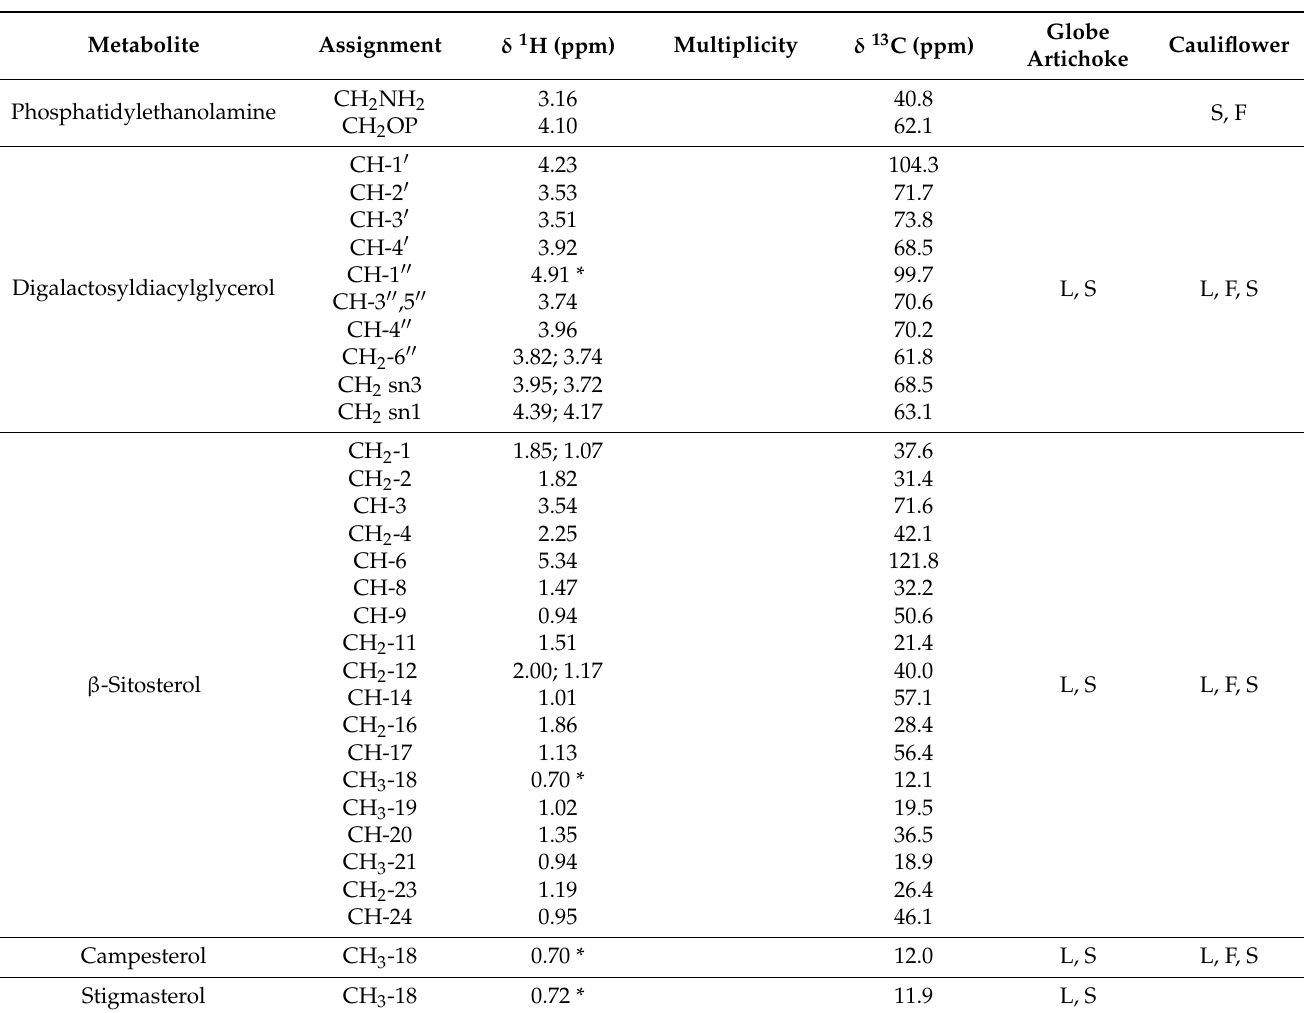
(Table 3). The characteristic singlet signal at 0.70 ppm is due to 18-CH 3 group of both campesterol and β -sitosterol that cannot be separated in the 1 H NMR spectra and were quantified as a